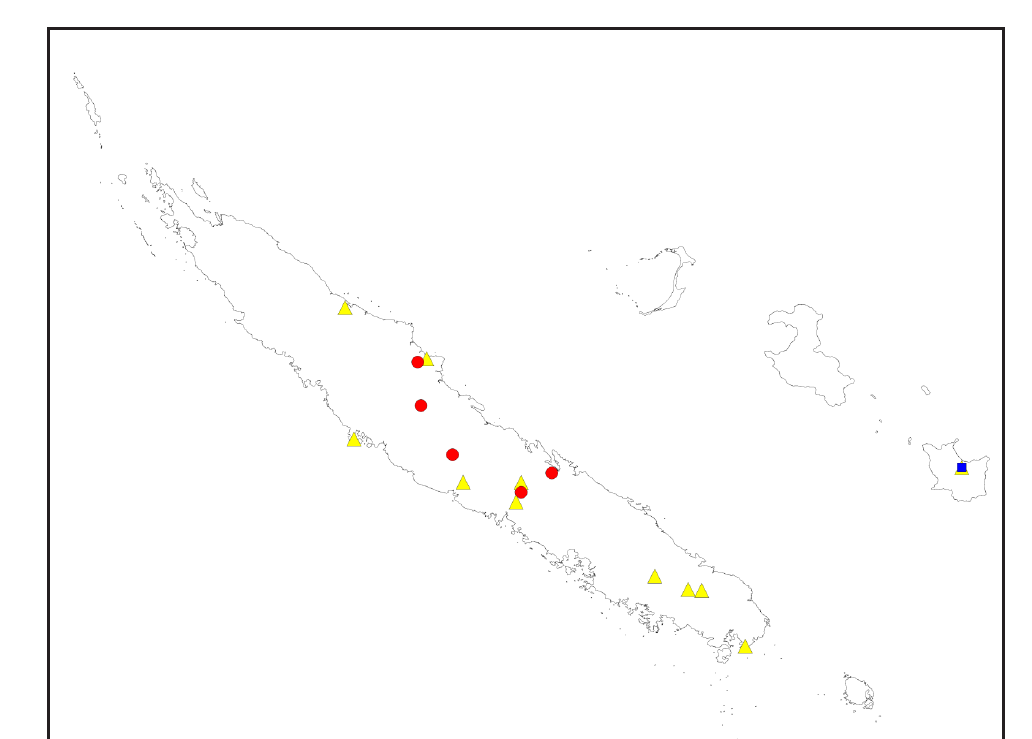
Fig. 9. Recorded localities of C. insignipes (Simon, 1880) (circle), C. foeldvarii Szűts, 2002 (triangle) and C. logunovi sp. nov. (square) in New Caledonia and the Loyalty Islands.